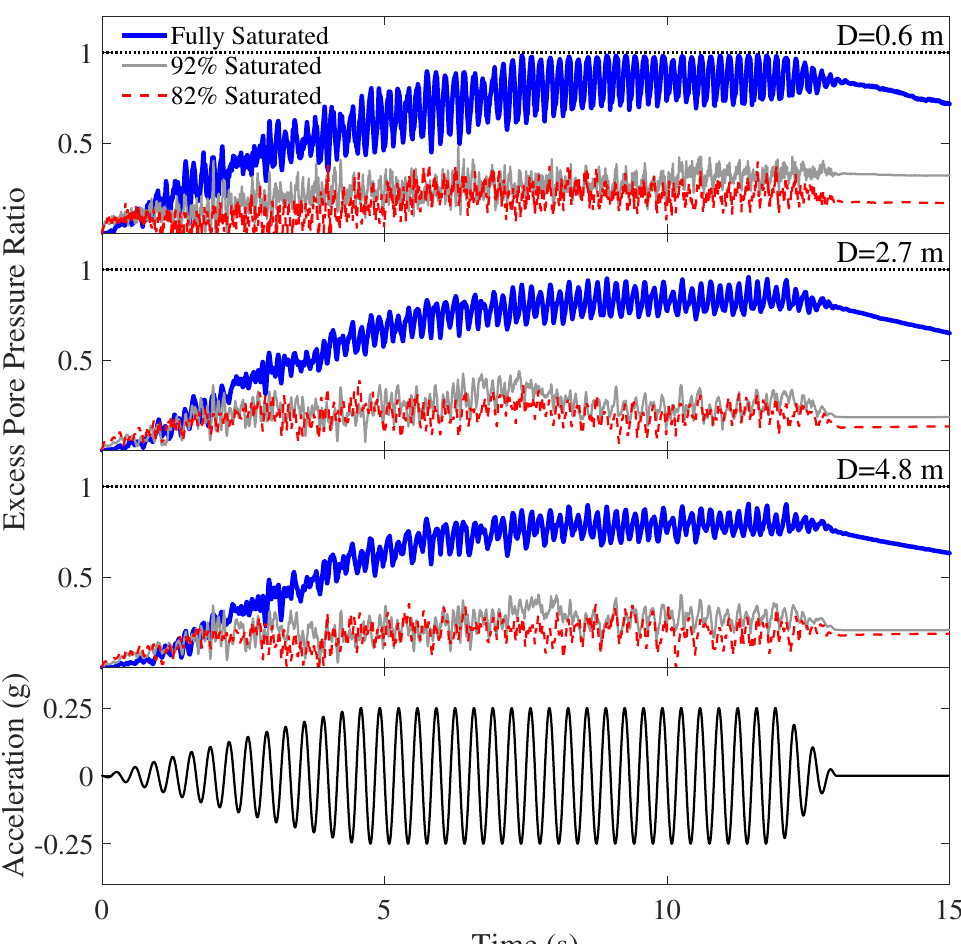
Figure 8. Time histories of the excess pore pressure ratio at selected depth locations for soil deposits with different degrees of